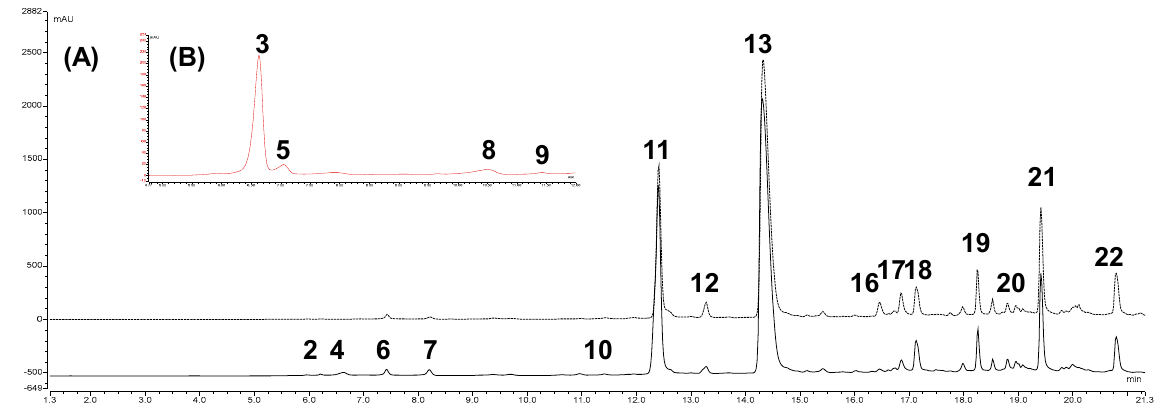
Figure 1. ( A ) UHPLC ‐ UV profile (365 nm) of “Rossa di Tropea” onion skin (solid line) and “Ramata di Montoro” onion skin extract (dashed line); ( B ) UHPLC ‐ UV profile (520 nm) of “Rossa di Tropea” onion skin.